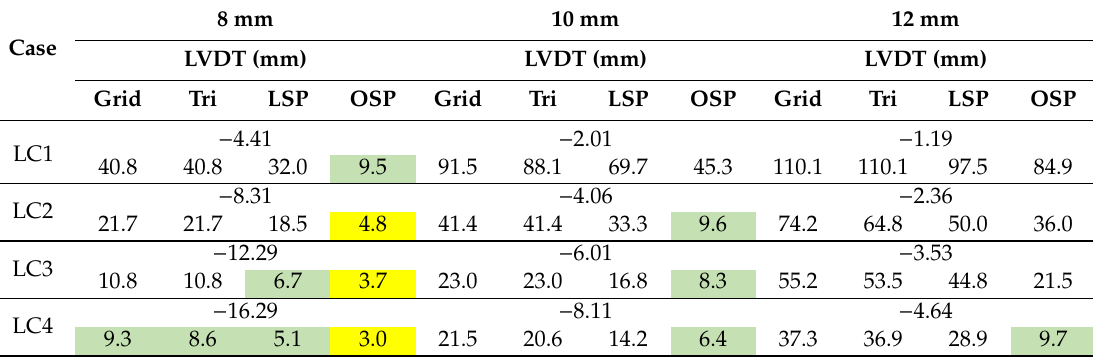
Table 11. Comparison of error rates between LVDT and the four methodologies. Color display of error rate ( Green : within 10%, Yellow : within